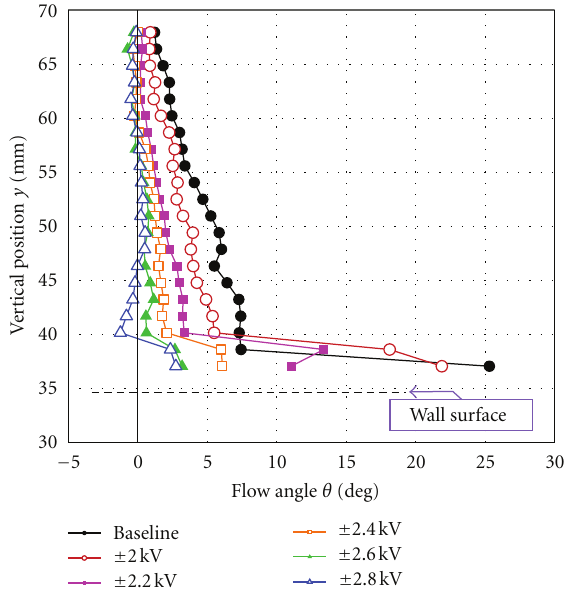
Figure 9: Streamwise velocity distributions near plasma actuator ( x = 29.7mm).